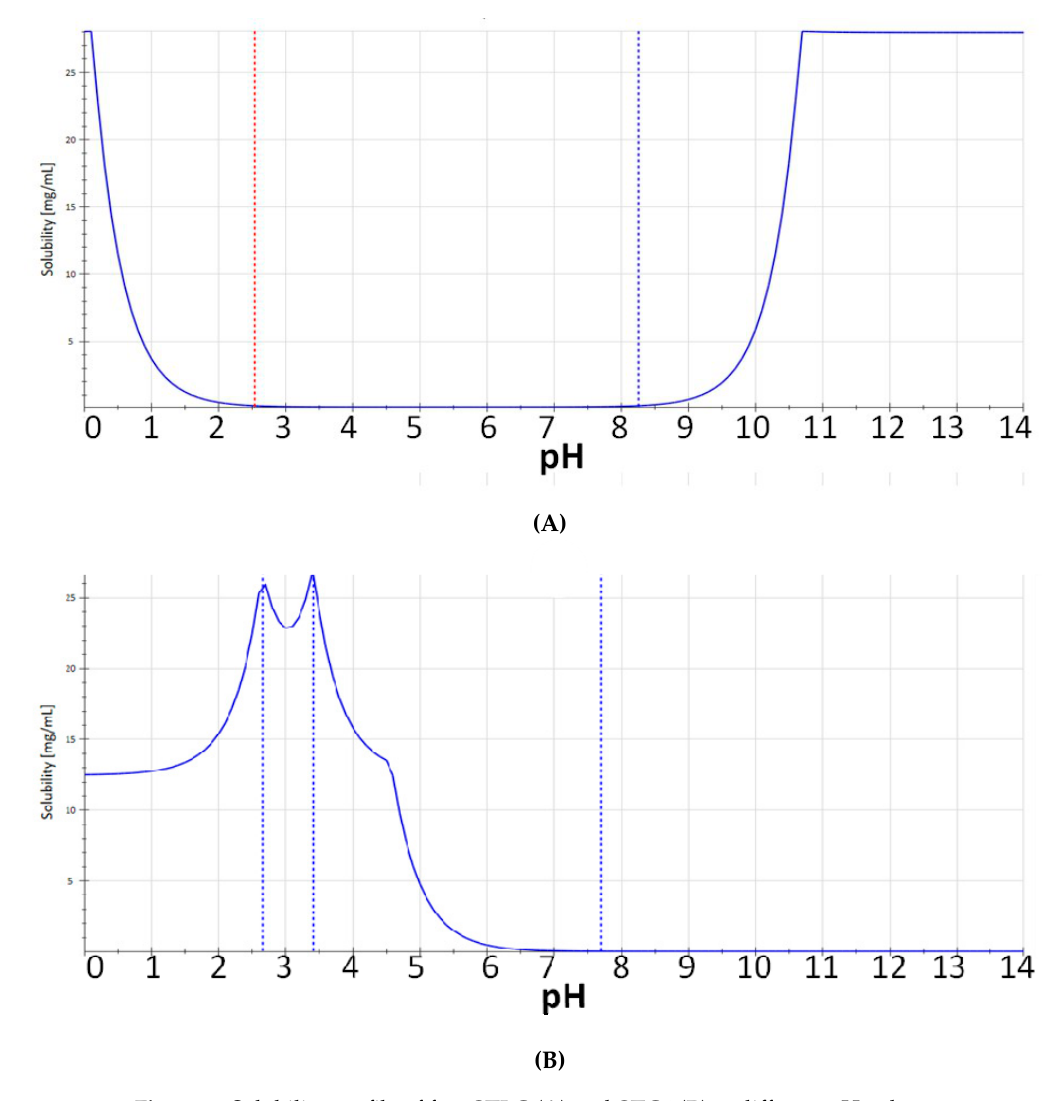
Figure 5. Solubility profile of free STLC ( A ) and STC4 ( B ) at different pH values.